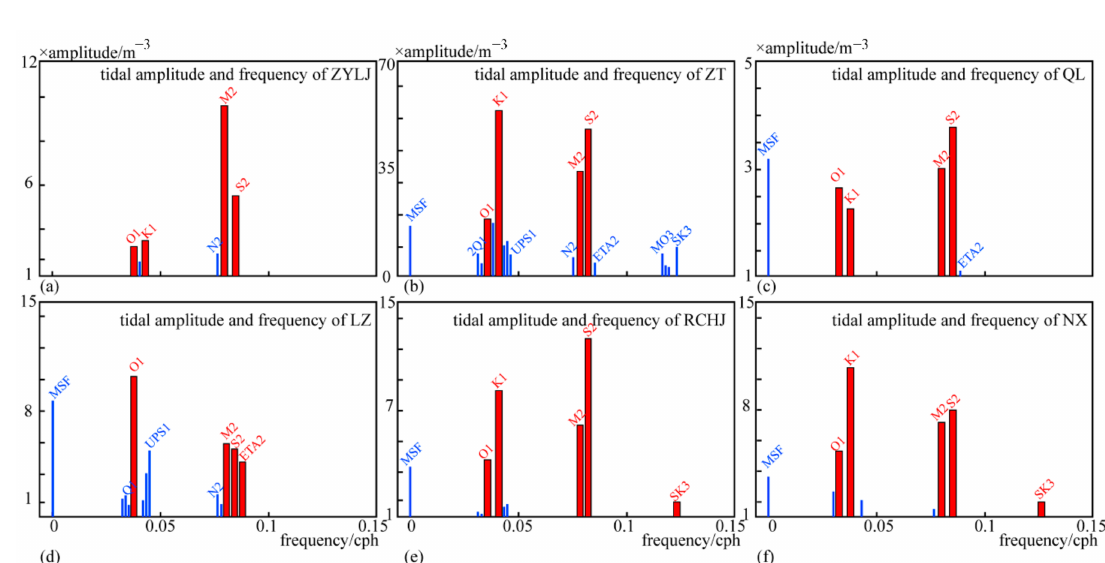
Figure 7. Tidal amplitude and frequency of water level fluctuations in the ZYLJ ( a ), ZT ( b ), QL ( c ), LZ ( d ), RCHJ ( e ) and NX ( f ) wells. The values below the resolution of probe are removed. The software adopted to carry out FFT analysis is retrieved from the website of https://www.eoas.ubc.ca/~rich/#T_Tide (accessed on 7 June 2021). The red bars represent the components with SNR ≥ 2. SNR: signal noise ratio.